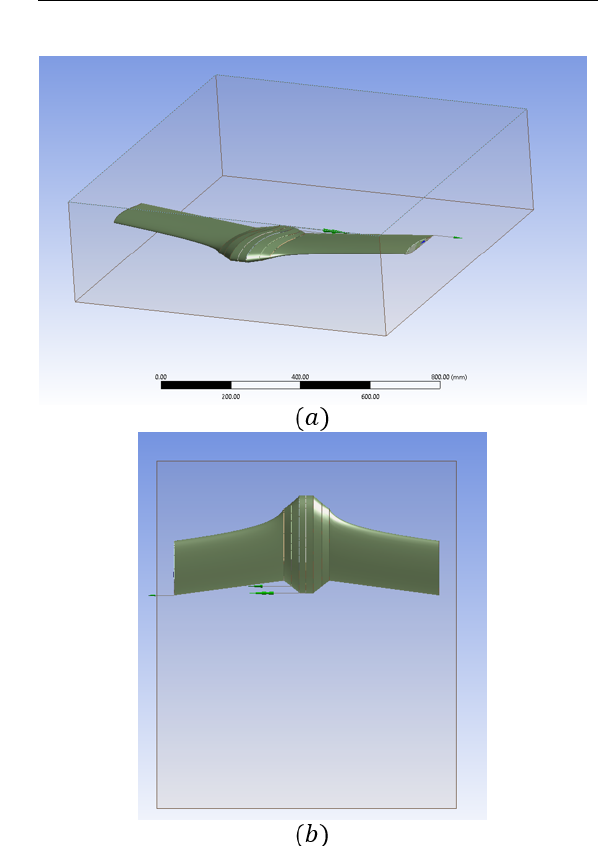
Figure 11. Computational domains for CFD simulation: ( a ) Isometric view, ( b ) Top